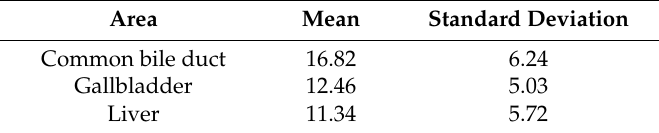
Figure 4. Typical LDF signals in the areas of interest ( a ) and Box-Whisker diagram of mean perfusion ( b ). * Confirmed statistically significant differences. The level of significance was estimated using a one-way analysis of variance ( p < 0.05) Table 2. Average values of LDF